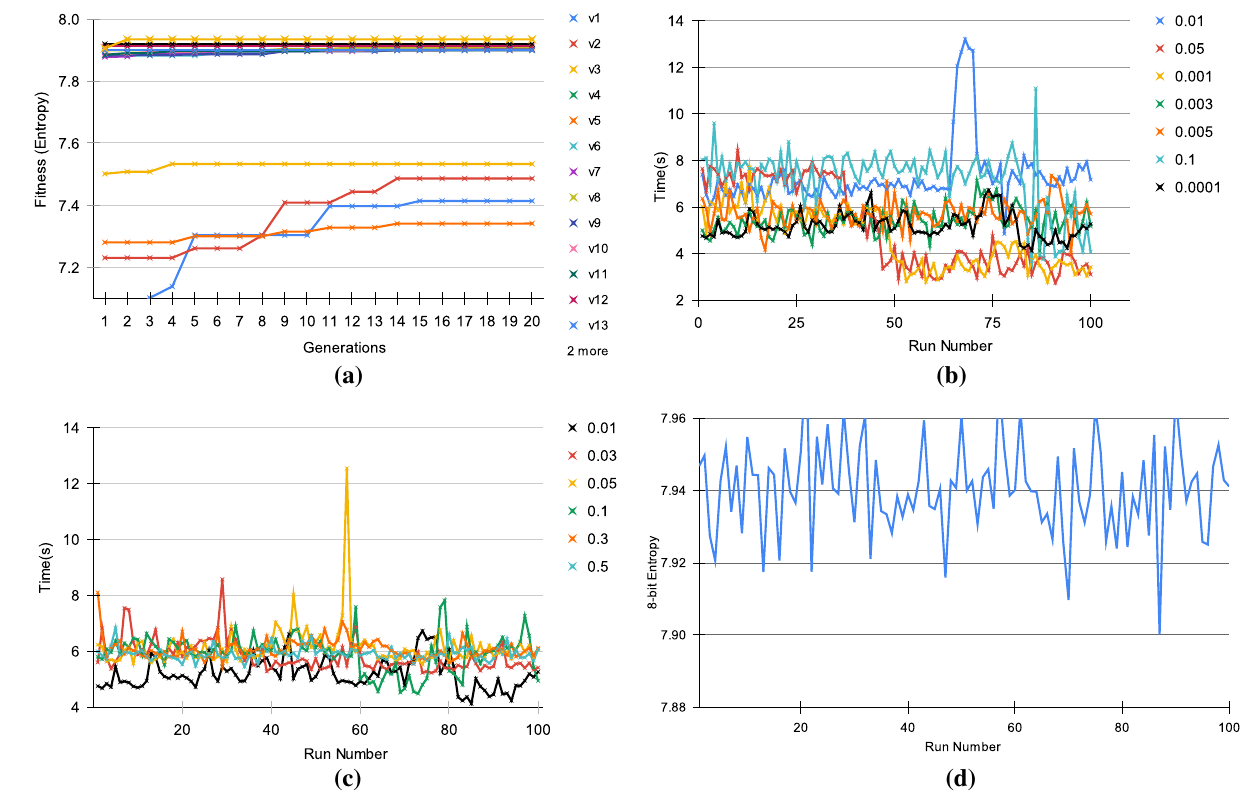
Figure 2. Tuning of BNF grammar and genetic operators, mutation and crossover, to obtain the optimal entropy. In all combinations of the BNF Grammar as depicted in ( a ) where 20 generations were sufficient to obtain the optimal entropy. The initial seed leading to optimal entropy using the 15th version of BNF Grammar was secured with SHA3-512, whereas in the previous 14 versions, the hashing algorithm SHA2-512 was used to secure the initial seed. In all of the cases, the entropy remained in the range 7.92 to 7.94. ( b ) Values for crossover were varied from 0.0001 to 0.1 while keeping mutation fixed at 0.01. With the value of 0.0001, the optimal entropy remained consistent and the time taken to obtain the entropy was also consistent for that value. Similarly, in ( c ), we vary the mutation rate from 0.01 to 0.5 while keeping crossover fixed at 0.001. In this case, the most consistent value for time taken was exhibited by a mutation rate of 0.01. Finally, these two values were used with the 15th BNF grammar version to produce an optimal entropy value of 7.940560934 from 100 runs as illustrated in ( d ).